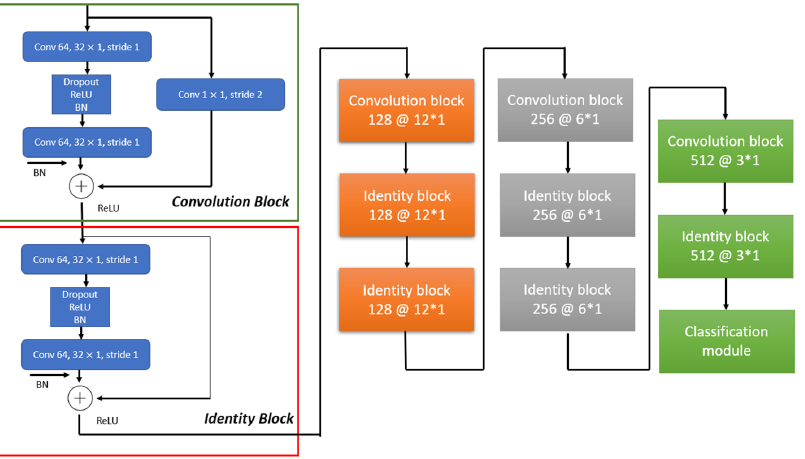
Figure 7. ResNet Module architecture. The ResNet module consists of a combination of Convolution block and Identity blocks. (*) represents the number of blocks of each type.